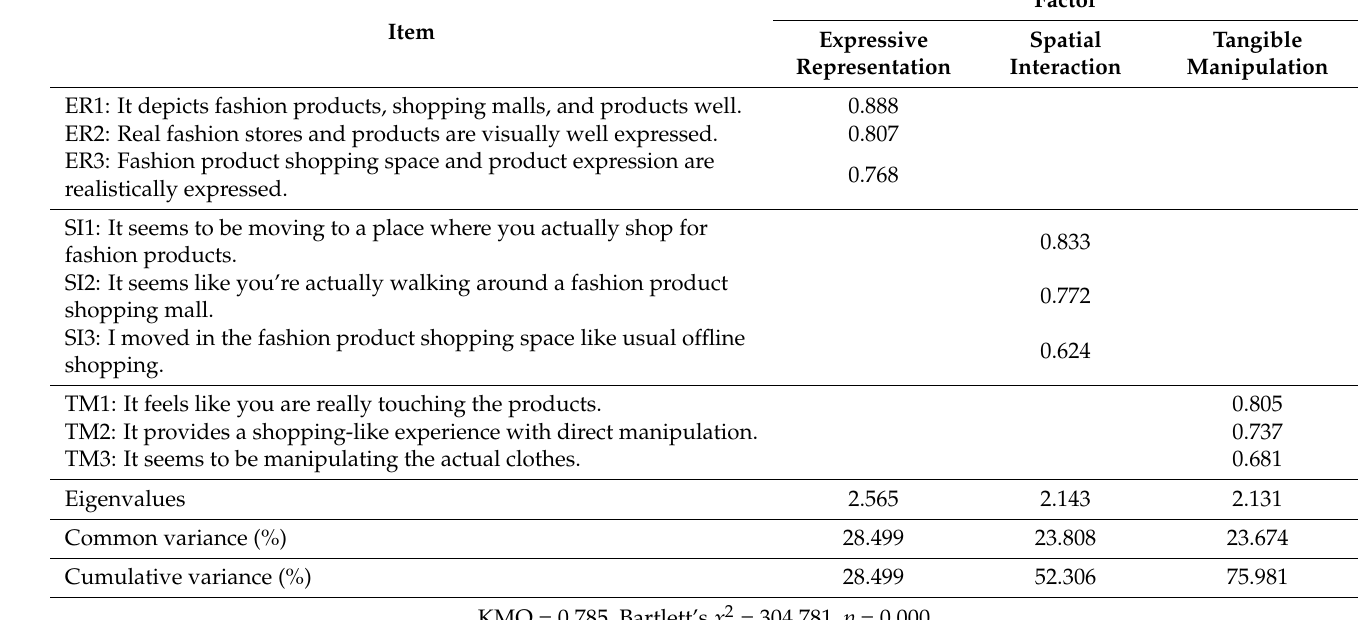
Table 5. Result of factor analysis for tangible